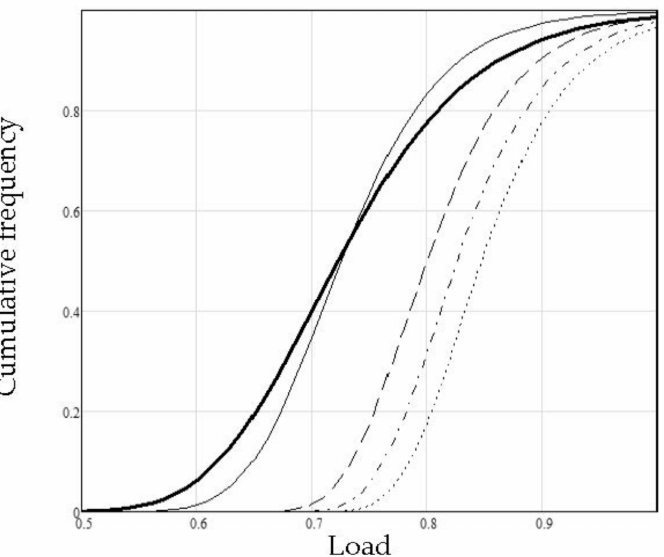
Figure 3. Cumulative load distributions for 50-year variable load and group of permanent loads with 1, 50, 500, and 5000 permanent loads, thin solid line, dashed line dash-dotted line and dotted line, 50-year variable load and one permanent load with the DLC is shown with thick solid line.